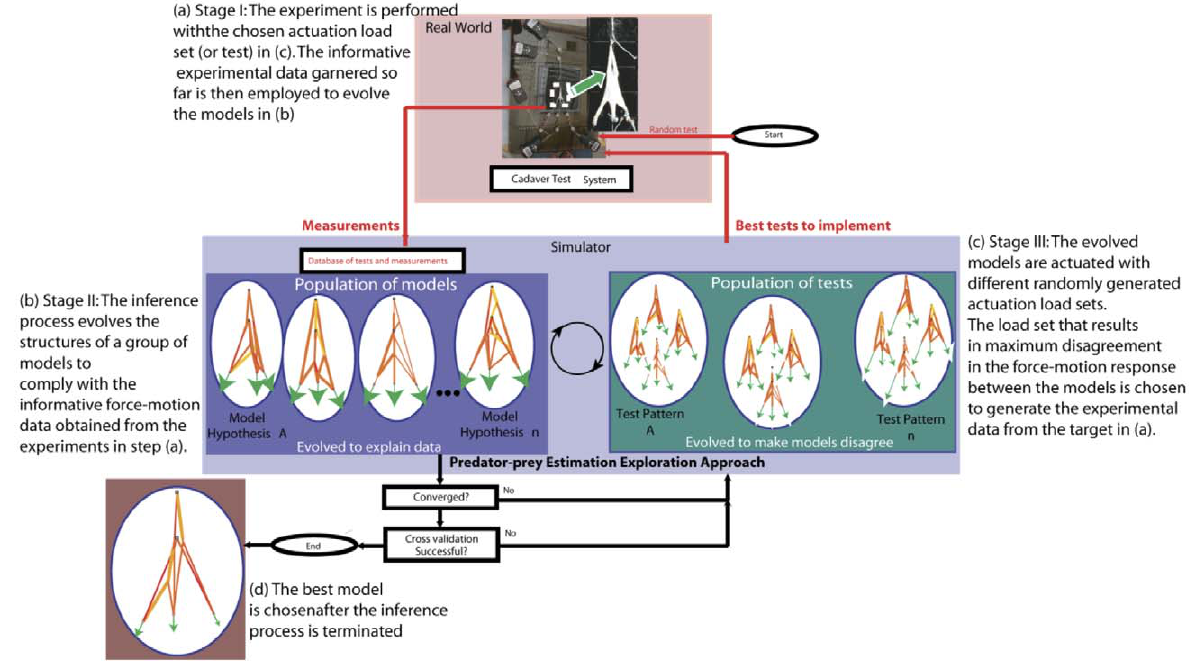
Figure 1. Concept depiction – the structural constitution of the hidden complex tendinous networks (e.g., inset in a) can be inferred via the most informative force-motion data. Steps (a)–(c) are performed cyclically until a termination criterion is met after which the best model (d) is chosen. (c) represents the evolved models from step (b) being actuated by a random set of input forces (or tests) shown using arrows. The length of each arrow represents the magnitude of the force applied. The actuation directions may or may not be held fixed (here, shown fixed). The actuation force set that generates the maximum discrepancy in the force-motion response between the evolved models is chosen to perform the experiment in (a).